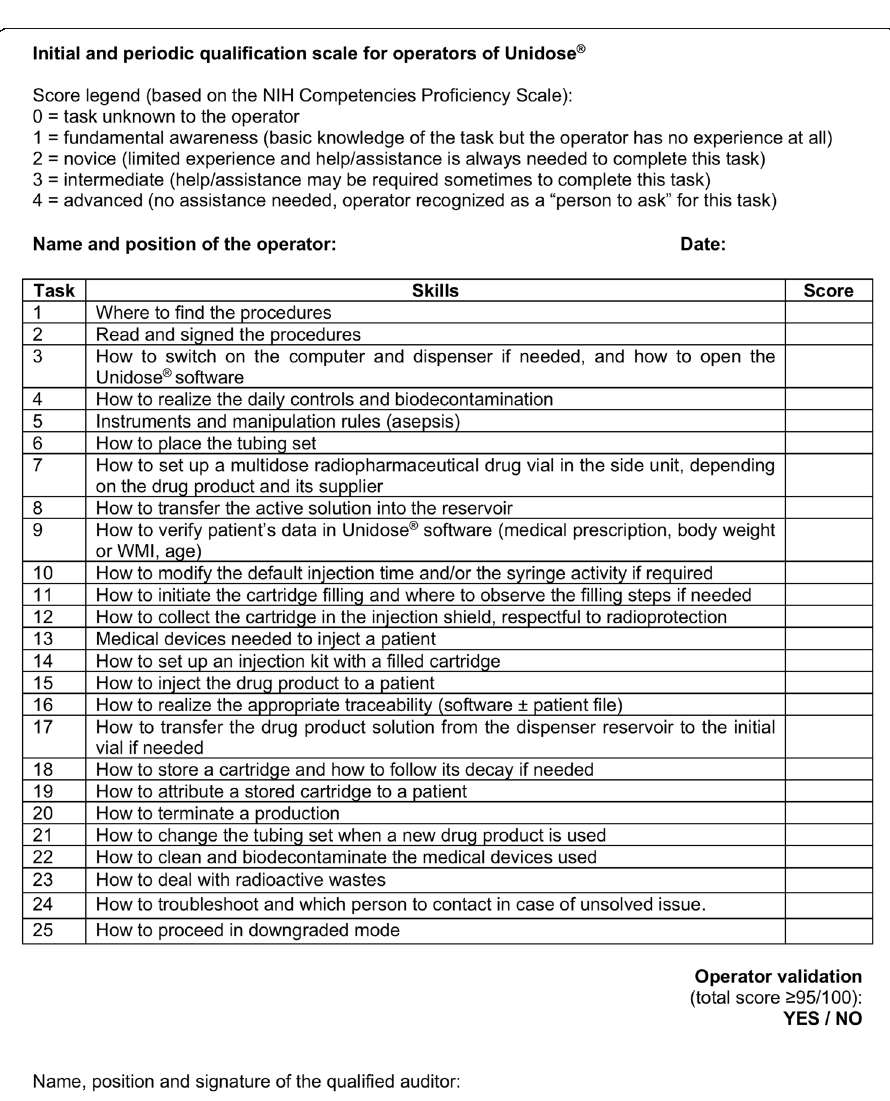
Fig. 2 Initial and periodic qualification scale for operators of